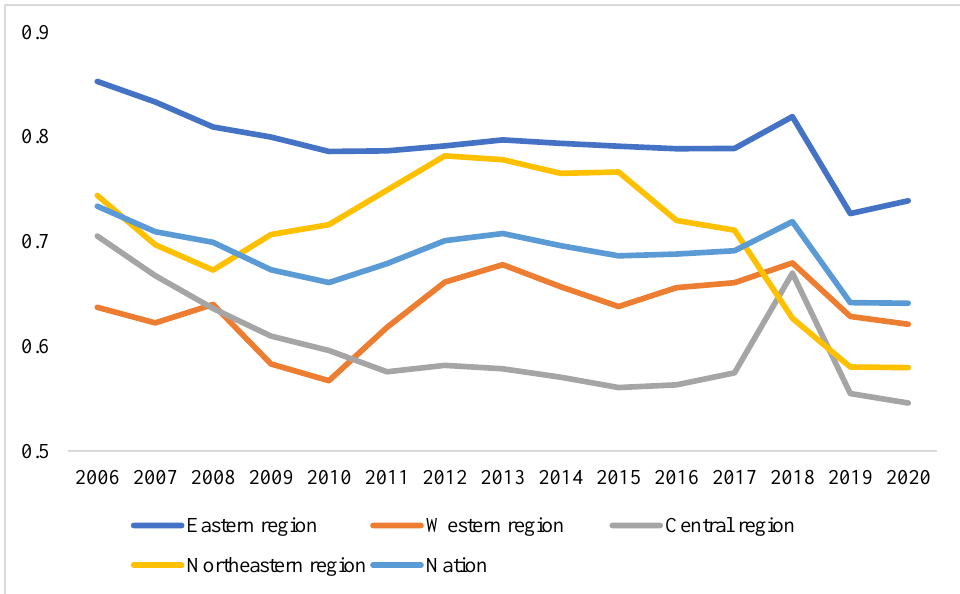
Figure 2. The evaluation trend of the IGGE in national and four regions, 2006–2020. Table 4. The IGGE in China from 2006 to